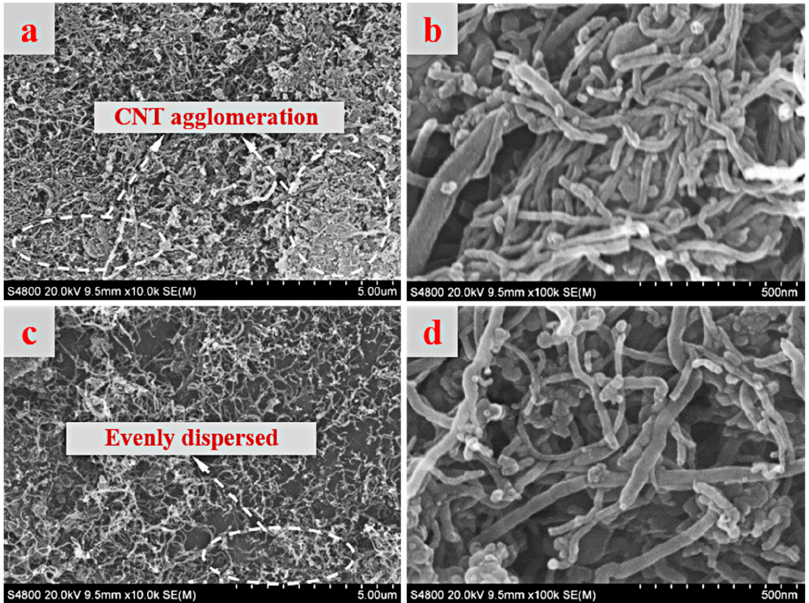
Figure 1. SEM images of ( a , b ) P-CNTs and ( c , d ) NS-CNTs.